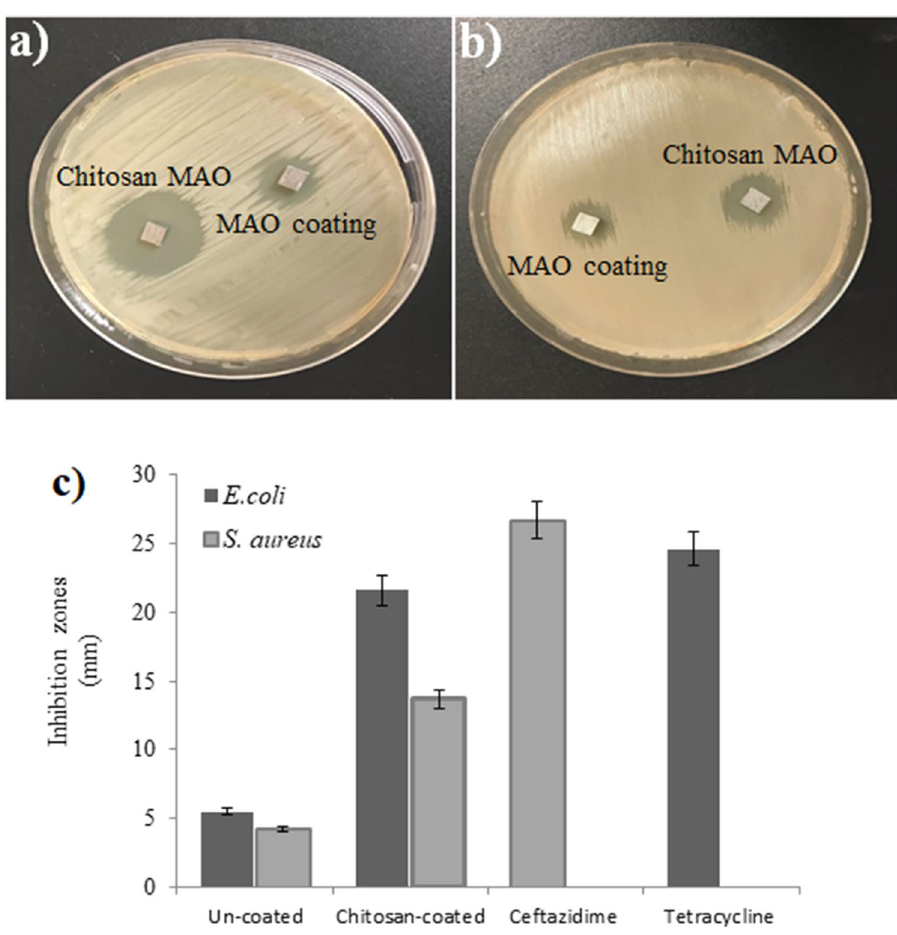
Figure 9. Inhibition zones of the MAO and chitosan-based MAO coated surfaces ( a ) E. coli , and ( b ) S. aureus and ( c ) inhibition zones (mm) of the MAO and chitosan-based MAO